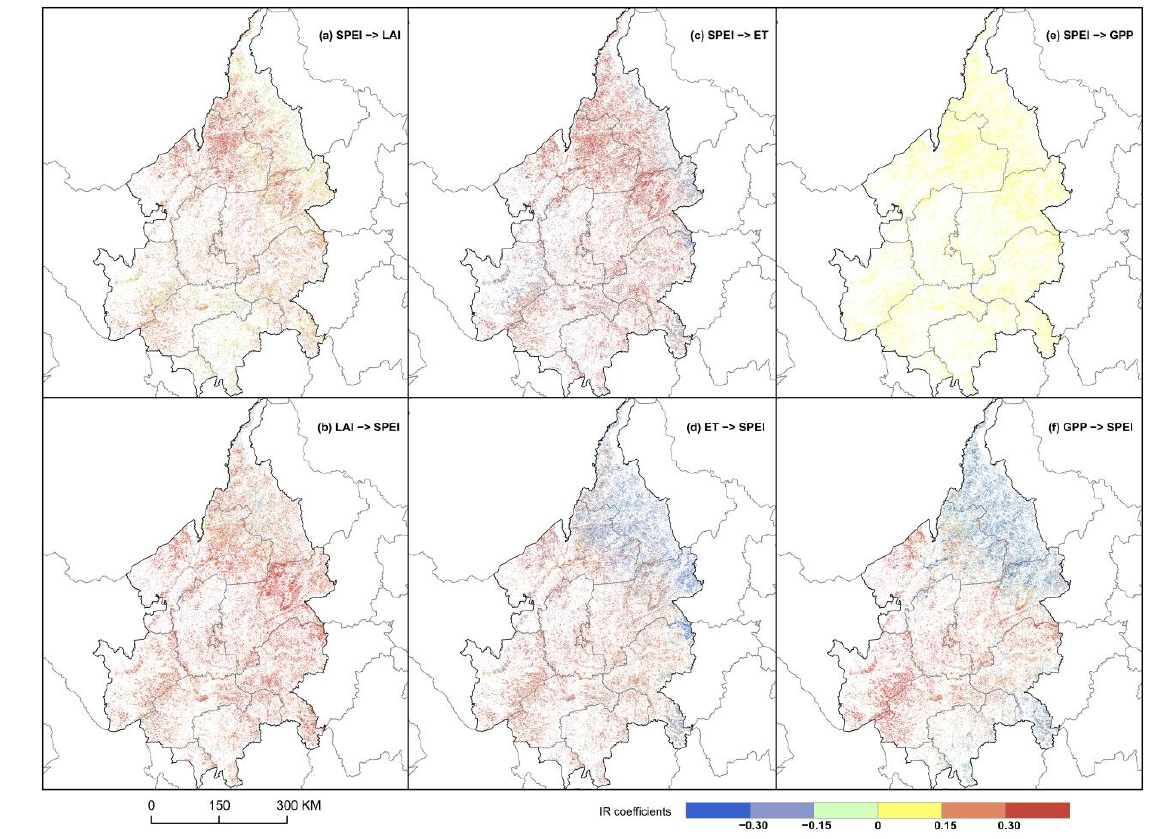
Figure 8. The cumulative impulse coefficients in 12 months after each group of variables were im- pacted with each other, i.e., SPEI and LAI ( a , b ), ET ( c , d ), GPP ( e , f